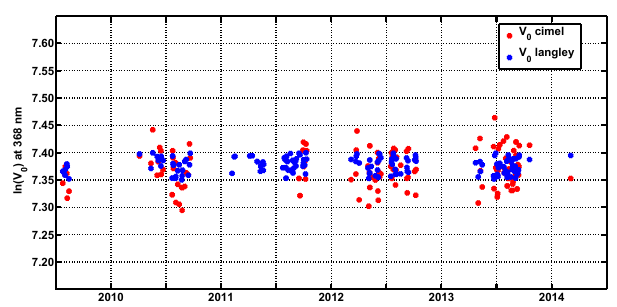
Figure 3. ETC values at 368nm, calculated using Langley plots of UVMFR measurements and using Cimel extrapolated AODs as input, for selected (low AODs and clear sky) days for the whole